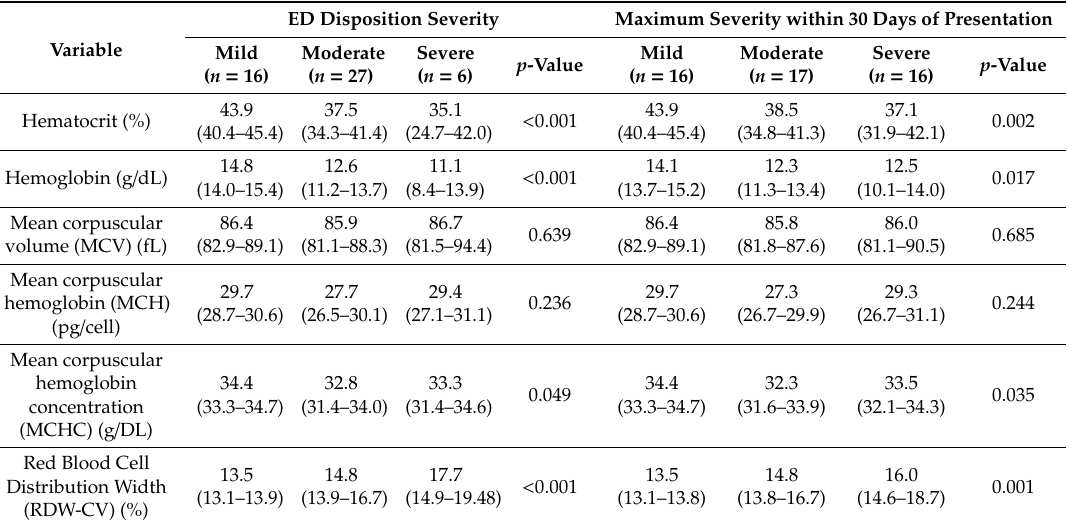
Table 2. Red Blood Cell Indices in Patients with